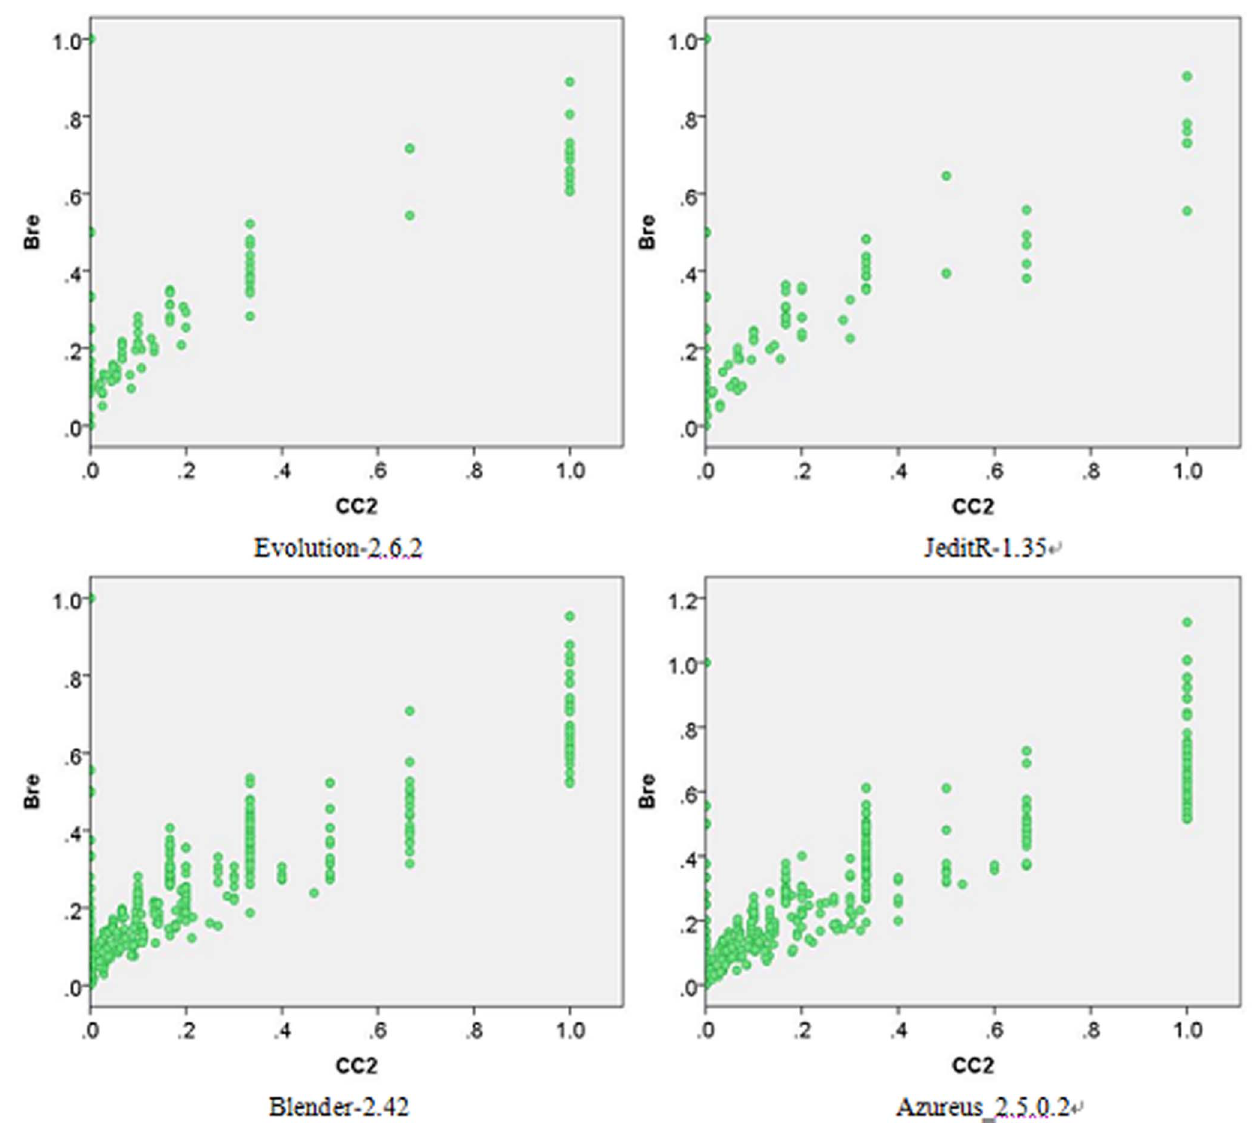
N represent measurements of the Bre models.